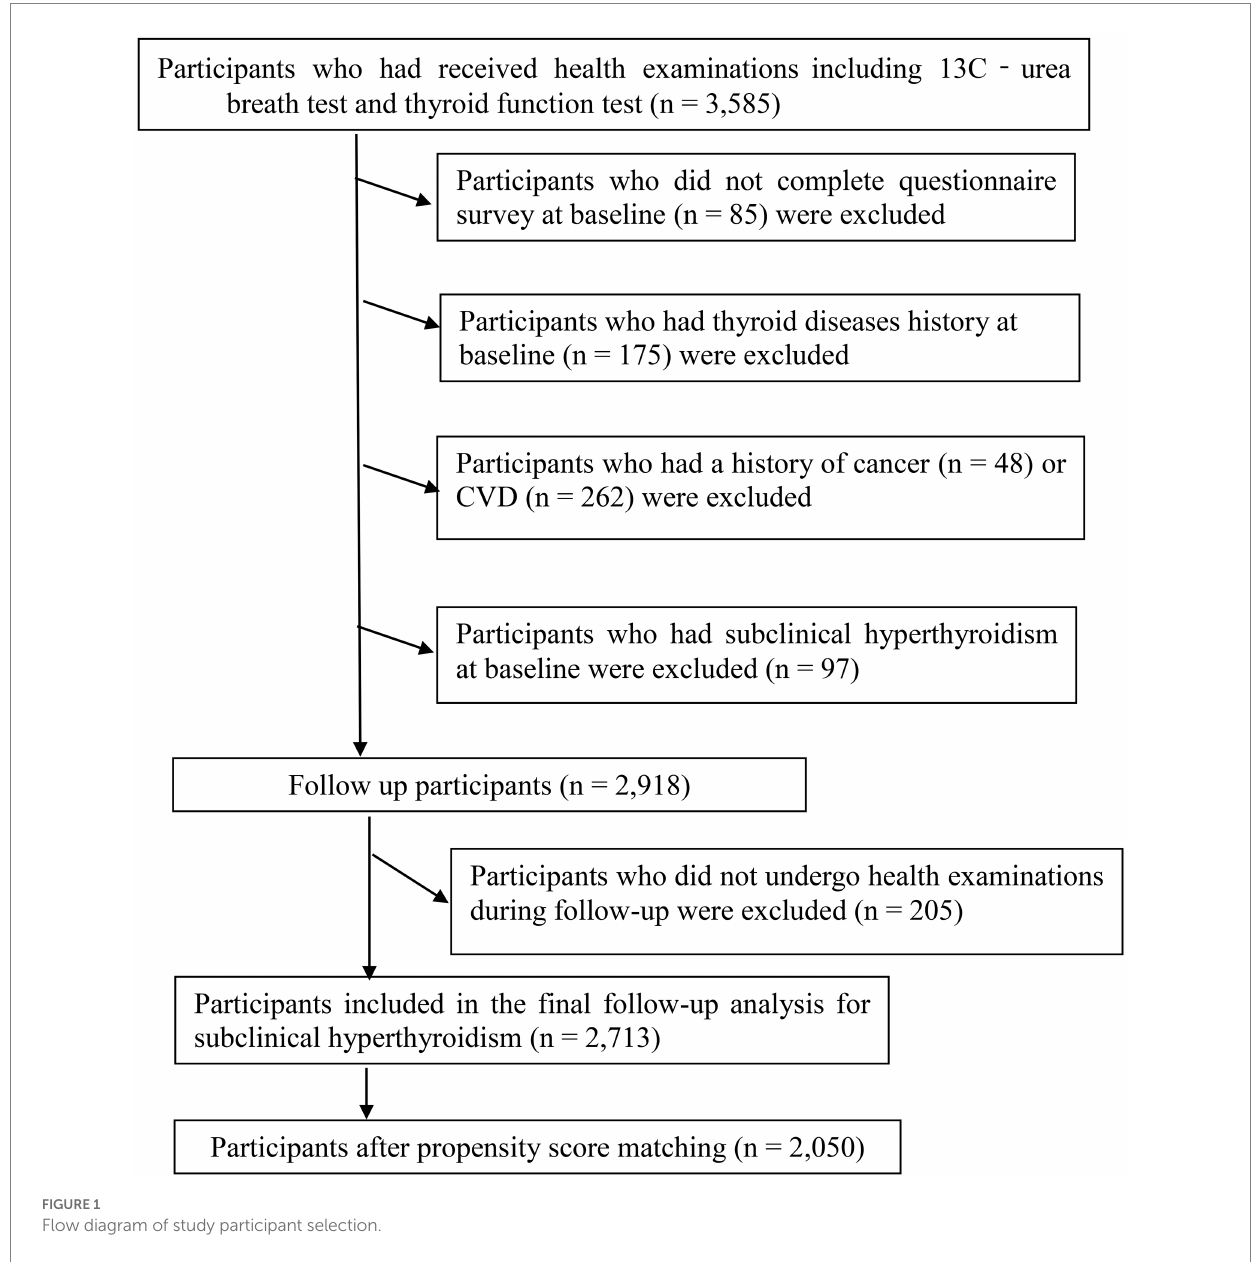
FIGURE 1 Flow diagram of study participant